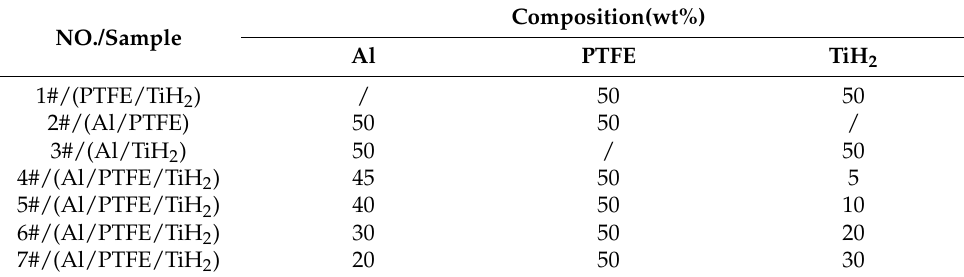
Table 4. Material composition ratio of oxygen bomb